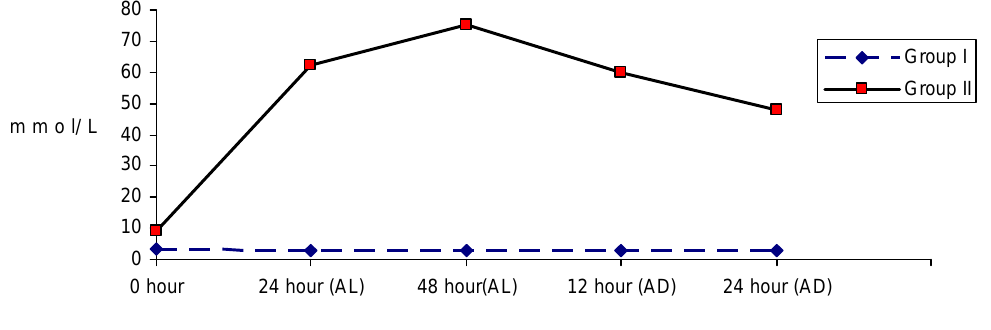
FIGURE 2. (SERUM UREA): Showing the serum urea level (mmol/L) at different time interval. AL = after ligation, AD = after dialysis